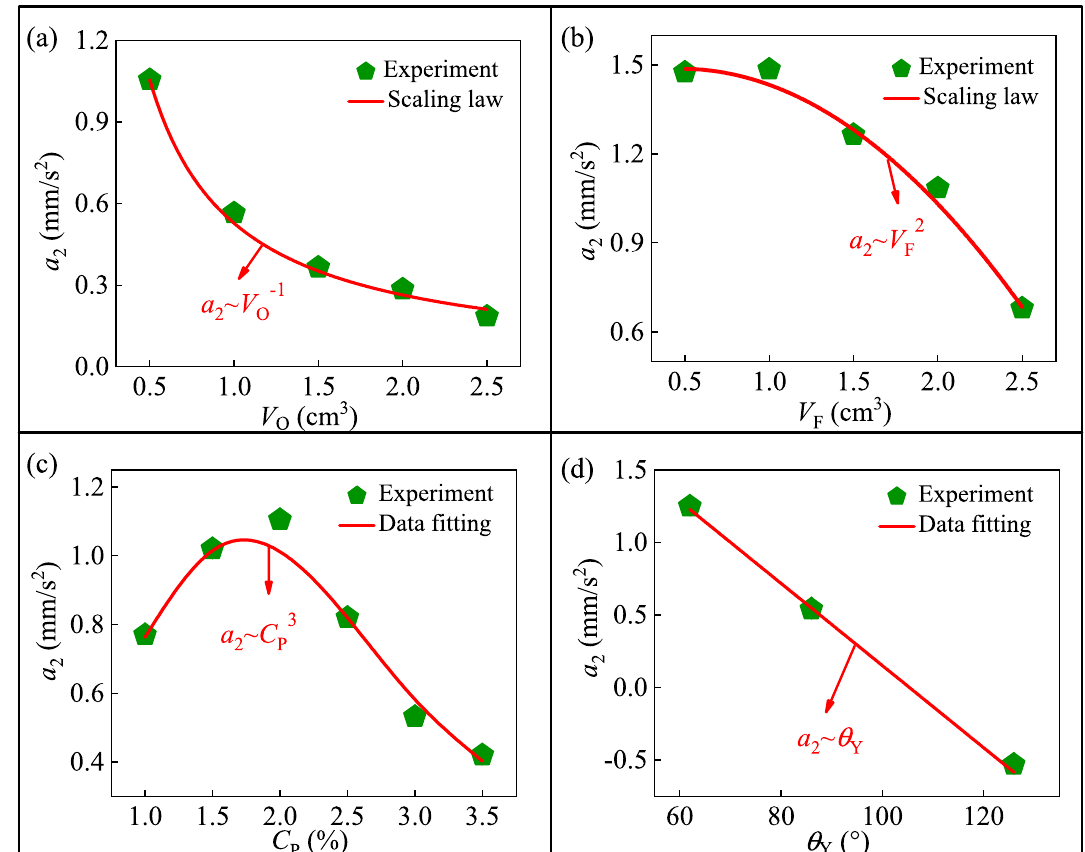
Figure 7. Dependence relationship between the maximum acceleration in the second stage a 2 and various parameters, i.e. ( a ) the volume of the oil drop volume V O , ( b ) the volume of the foam V F , ( c ) the concentration of the magnetic particles C P , and ( d ) the Young’s contact angle θ Y